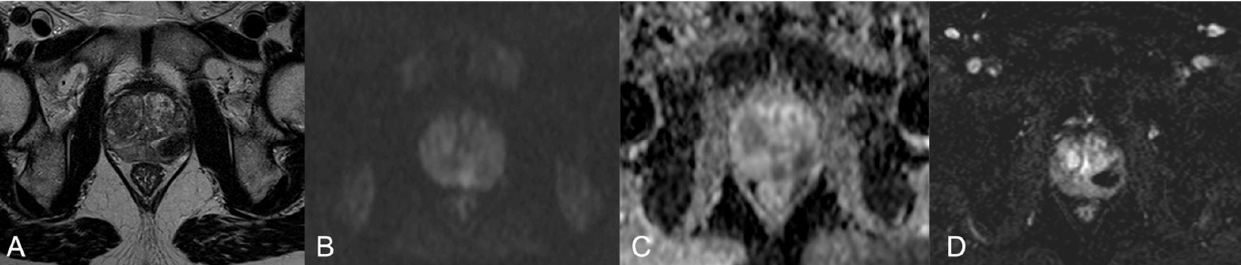
Figure 1. BCG-GP in a 62-year-old patient (case 1). MpMRI shows a 2-cm hypointense nodule in the left-middle lobe ( A ), predominantly isointense in DWI with a slightly hyperintense rim ( B ), marked low ADC value ( C ) and peripheral rim enhancement with a wide avascular core ( D ). PIRADS v2.1 4 PZpm mid-left.